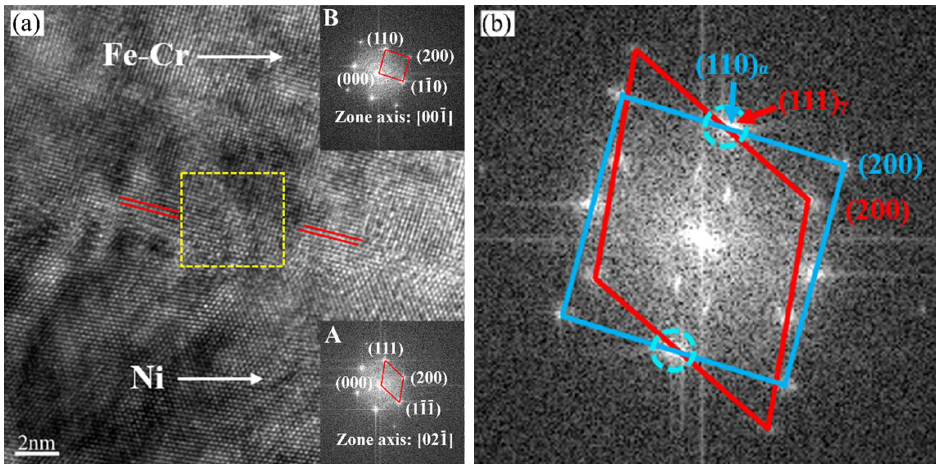
Figure 8. High-resolution transmission electron microscopy (HRTEM) observation of the joint interface subjected to tempering treatment and the corresponding FFT diagram: ( a ) HRTEM image at Ni/steel interface; ( b ) corresponding FFT diagram of the region marked with a yellow rectangle in ( a ).